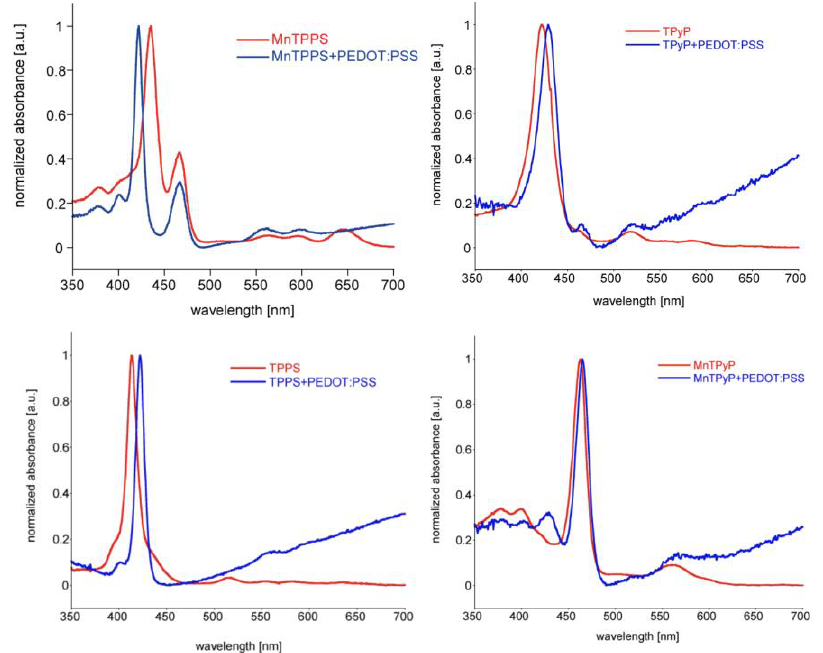
Figure 2. Absorption spectra of porphyrins and porphyrins – PEDOT:PSS mixture in water.